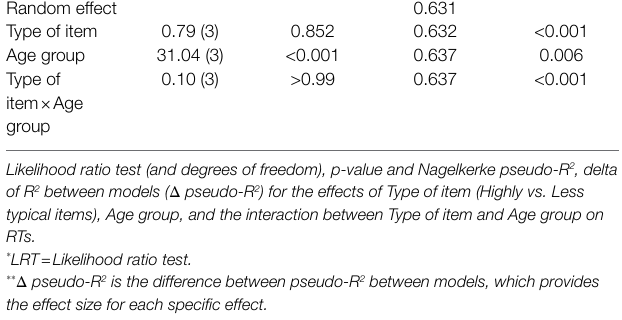
TABLE 4 | Results of the linear mixed model on reaction times (RTs) in Experiment 1. LRT * (df)